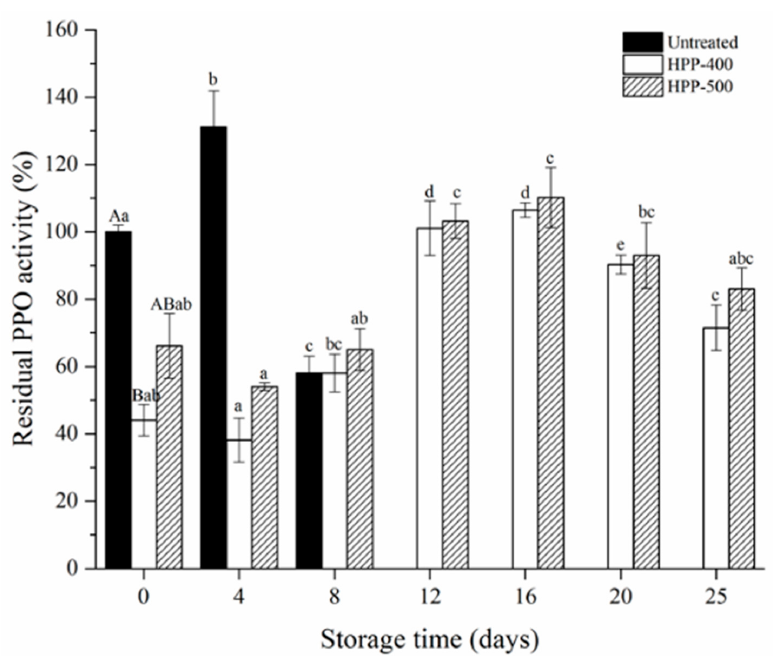
Figure 1. Changes in residual PPO activities of fresh-cut bell pepper during storage at 4 °C. The capital letters within one column indicate significant differences at day 0 ( p < 0.05). Values with different letters within one column are significantly different during storage ( p < 0.05).